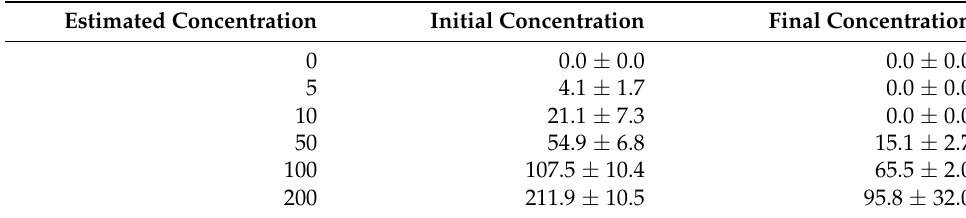
Figure 4. The effects of different sulfide concentrations on denitrification activities in the sediment at St. C measured using the acetylene blockage method. St. C measured using the acetylene blockage method. Table 2. Estimated, initial, and final sulfide concentrations (mg-S L − 1 ) to determine the effect of sulfide on denitrification. The initial and final concentrations were measured on days 0 and 21,